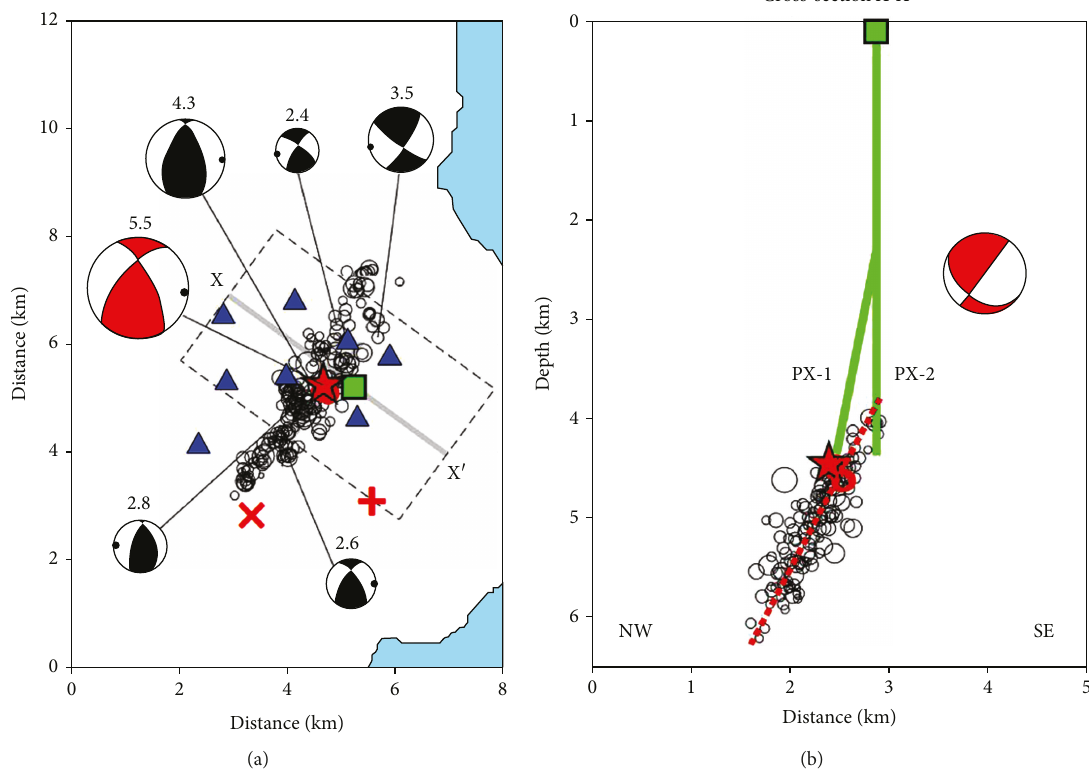
Figure 2: Locations of earthquakes at Pohang in November 2017: foreshocks (red circles), the 15 November mainshock (red star), and aftershocks (black circles). Also shown are stations of the local seismograph network (blue triangles), the EGS site (green square), the thermal spa resort ( red + symbol ; coordinates from [97]), and the borehole that yielded the in situ stress measurements discussed by [58] ( red × symbol ). Focal mechanisms of the mainshock and fi ve principal aftershocks, each labelled by M back) focal hemisphere projections with compressional quadrants shaded. Modi fi ed from [7]. (a) map. (b) NW-SE cross-section along line illustrated in (a), showing schematically the two deep wells (solid green lines) and the interpreted plane of the Namsong Fault (dashed red